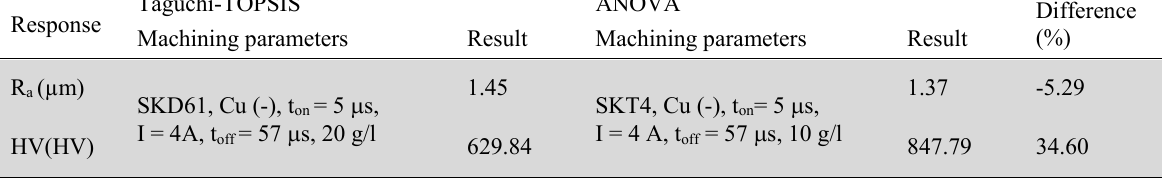
Comparison of optimization results using TOPSIS-Taguchi and ANOVA analysis